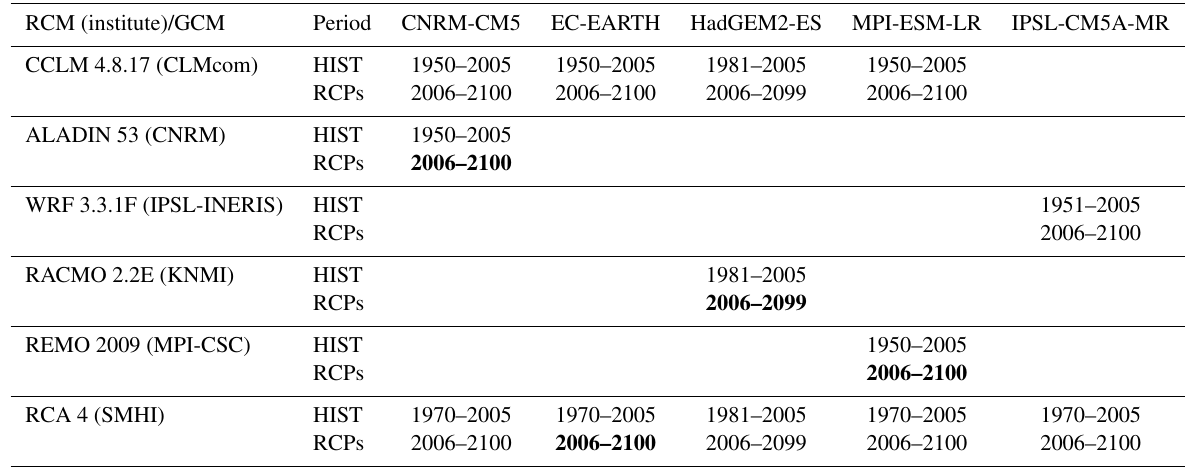
Table 1. EURO-CORDEX GCM–RCM combinations used in this study (rows: RCMs; columns: GCMs), with the time period available for the HIST and RCP 4.5 and 8.5 scenarios (RCPs). Model combinations additionally using RCP 2.6 are displayed in bold. Contributing institutes are indicated inside parentheses – CLMcom: CLM Community with contributions by BTU, DWD, ETHZ, UCD,WEGC; CNRM: